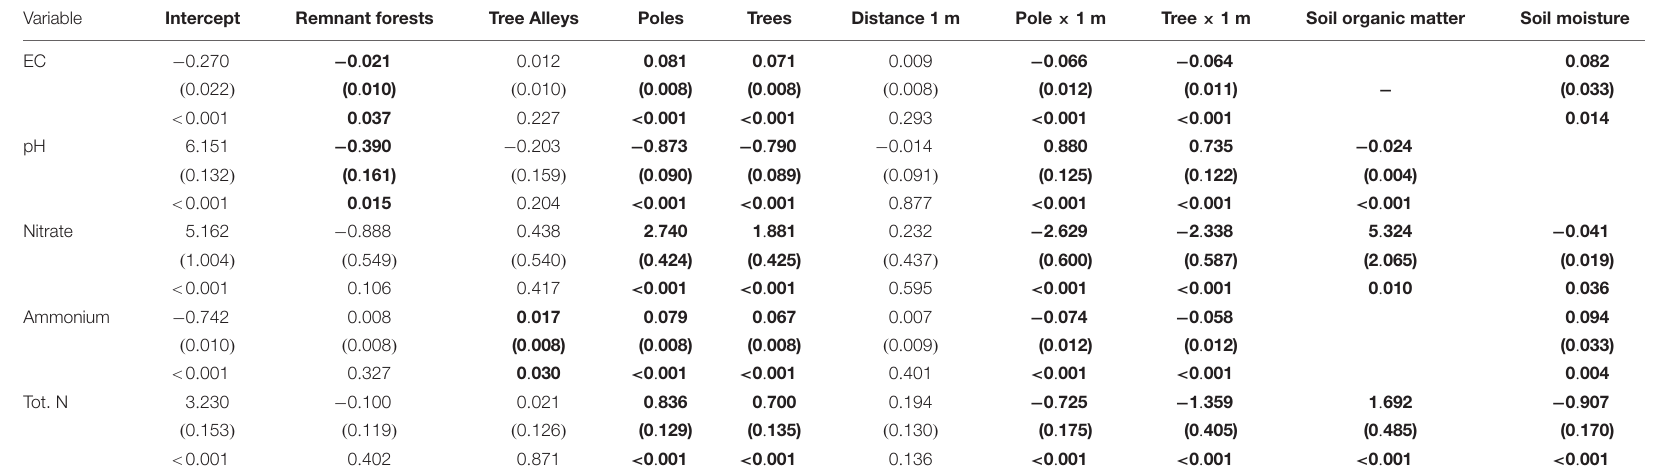
TABLE 2 | GLMM results, testing the effects of typology (a factor with three levels: Parks, Tree Alleys, and Remnant Forests), treatment (a factor with three levels: grass, pole, tree), distance (a factor with two levels: 0 and 1 m), and their two-way interaction on five variables (pH, EC, nitrate, ammonium, and tot.